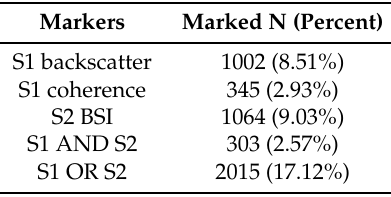
Table 5. Number and distribution of declared grassland parcels marked with S1 AND S2, S1 OR S2. Markers